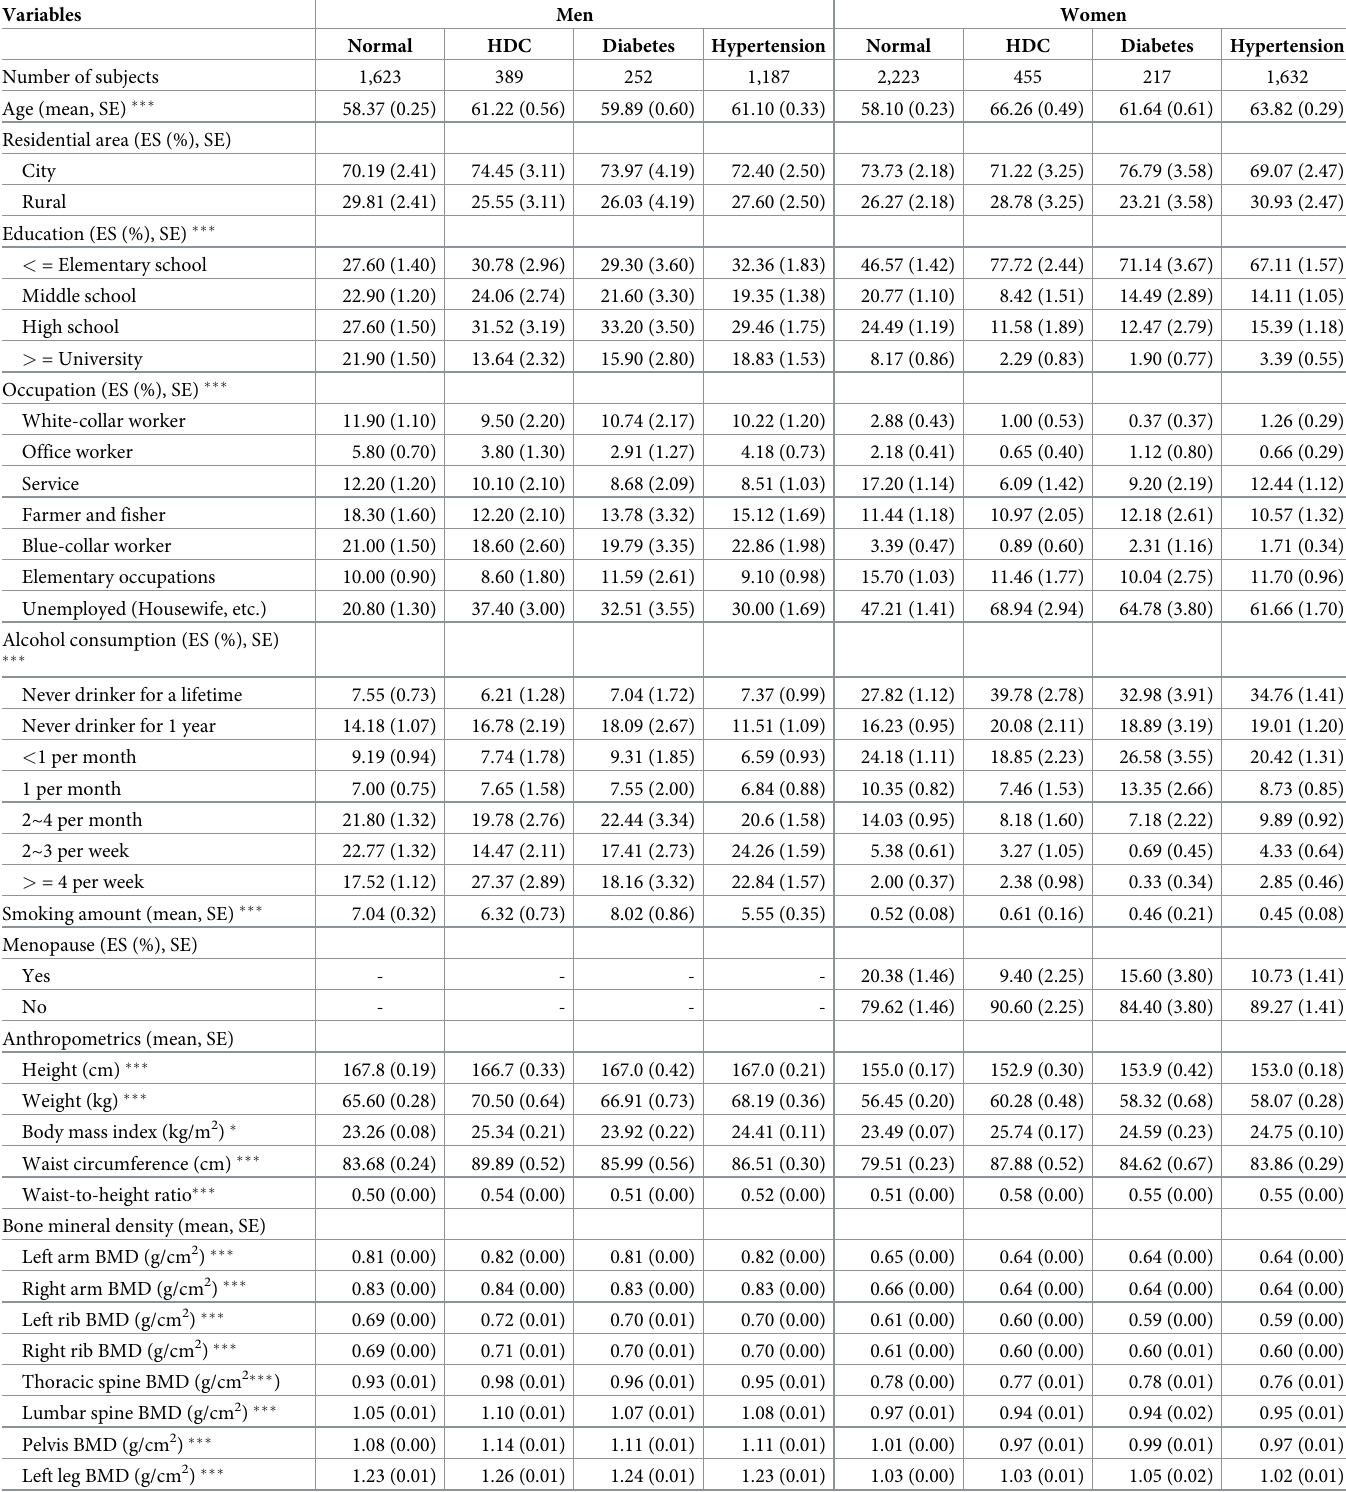
Table 1. Demographic